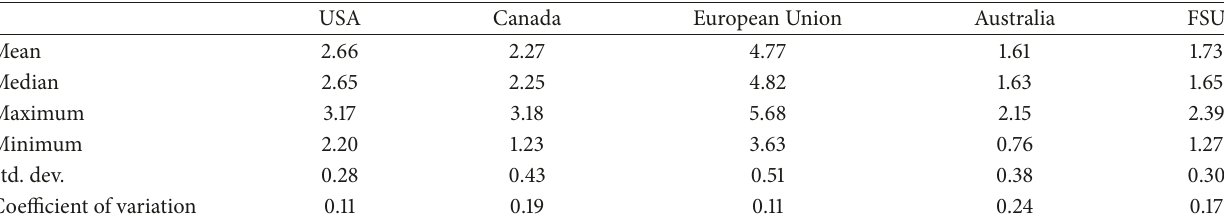
Table 5: Summary of yield data statistics